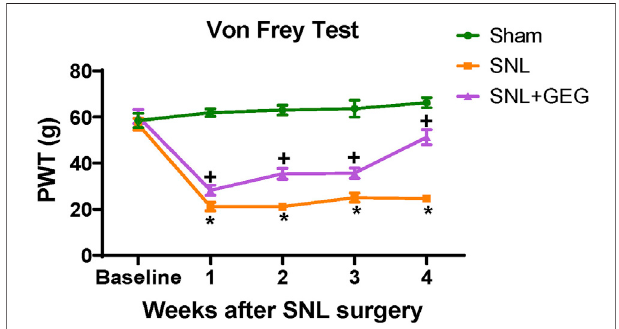
FIGURE 1 | GEG increased the mechanical thresholds of SNL rats as assessed by an electronic von Frey anesthesiometer. Data is expressed as mean ± SEM. n = 5 – 6 per group. Data was analyzed by mixed ANOVA followed by a post hoc Tukey ’ s test. * p < 0.05 vs. Sham. + p < 0.05 vs. SNL.